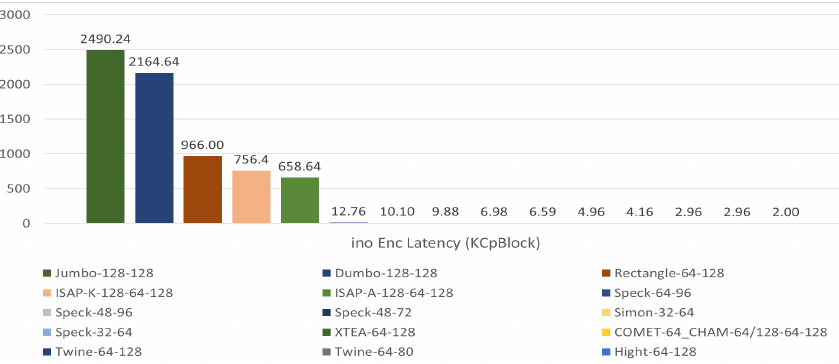
Figure 13. The 10 least speed latency in ENC and 5 biggest in